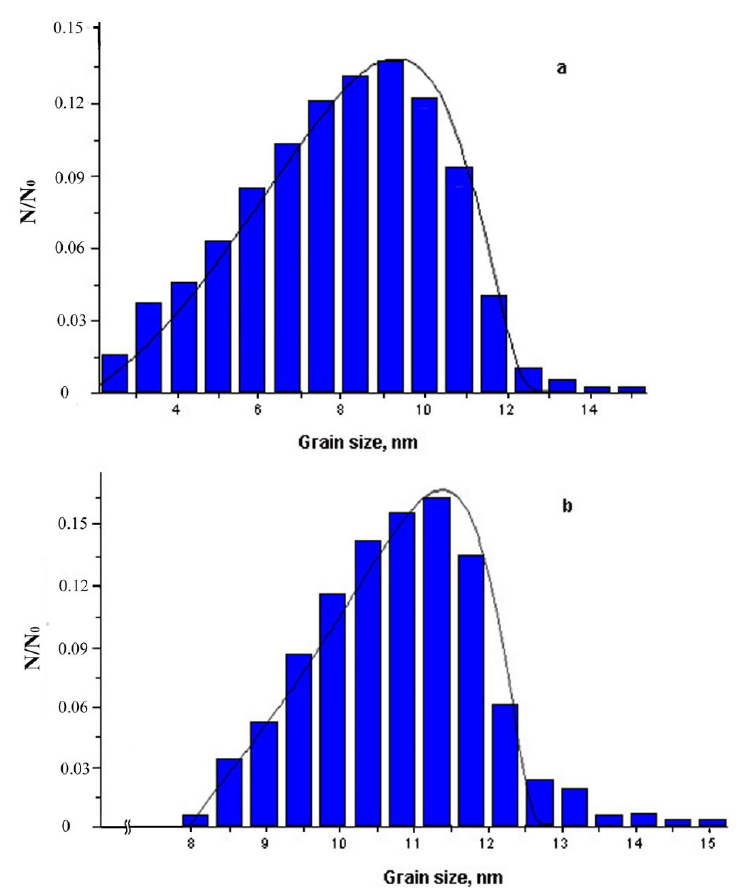
Figure 7. Nanocrystal distribution over size after annealling for ( a ) 5 and ( b ) 15 min. The theoretical data are marked with solid curves the experimental data are marked with columns [59] [reproduced from Physics of The Solid State 2001, 43, 2003 with permission from Pleiadis Publishing, 2020].